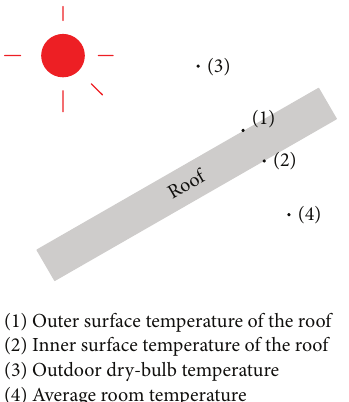
Figure 5: Temperature measurement points on the regular house under